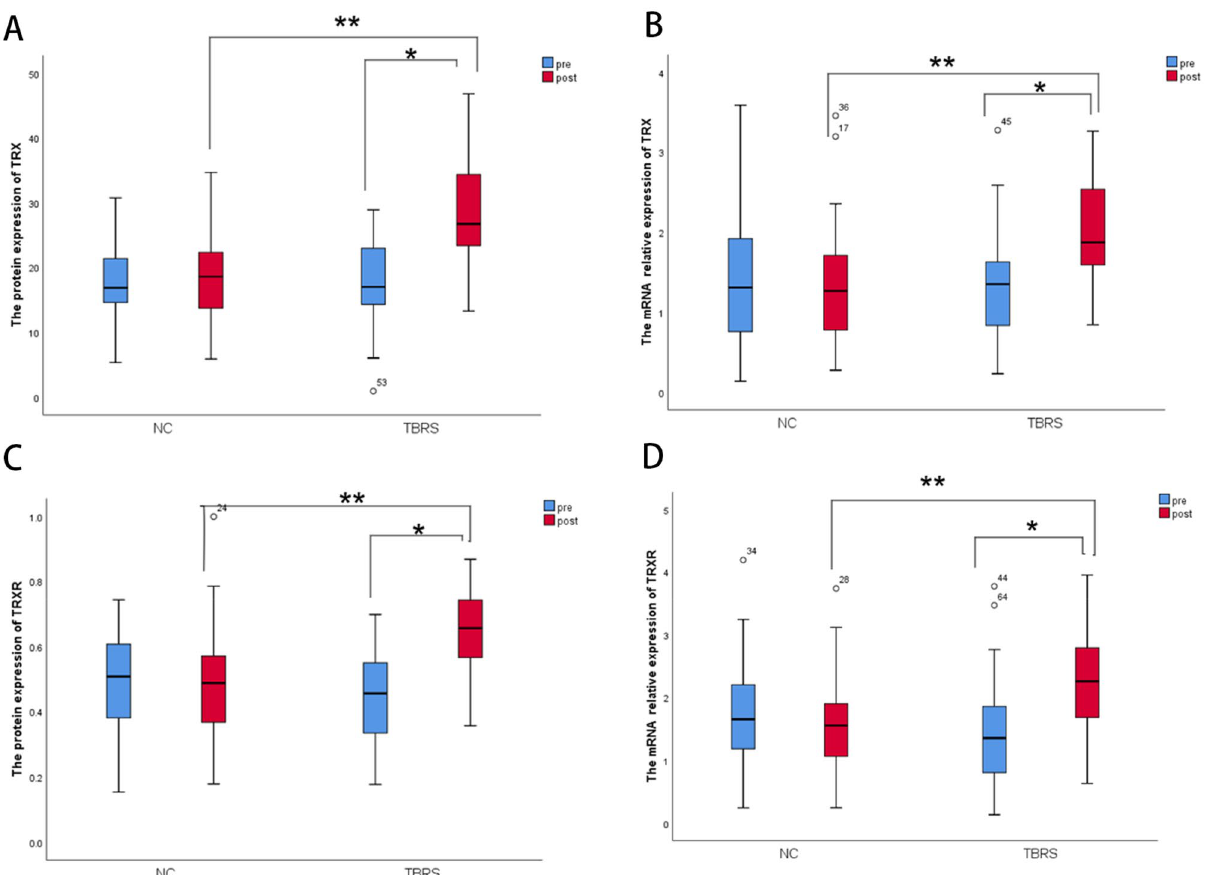
Figure 5. The expressions of TRX, TRXR protein and mRNA in the peripheral blood of the two groups before and after intervention. ( A ) the protein expression of TRX; ( B ) the mRNA relative expression of TRX; ( C ) the protein expression of TRXR; ( D ) the mRNA relative expression of TRXR; (* P = 0.00 compared with before intervention, ** P = 0.00 compared with the control